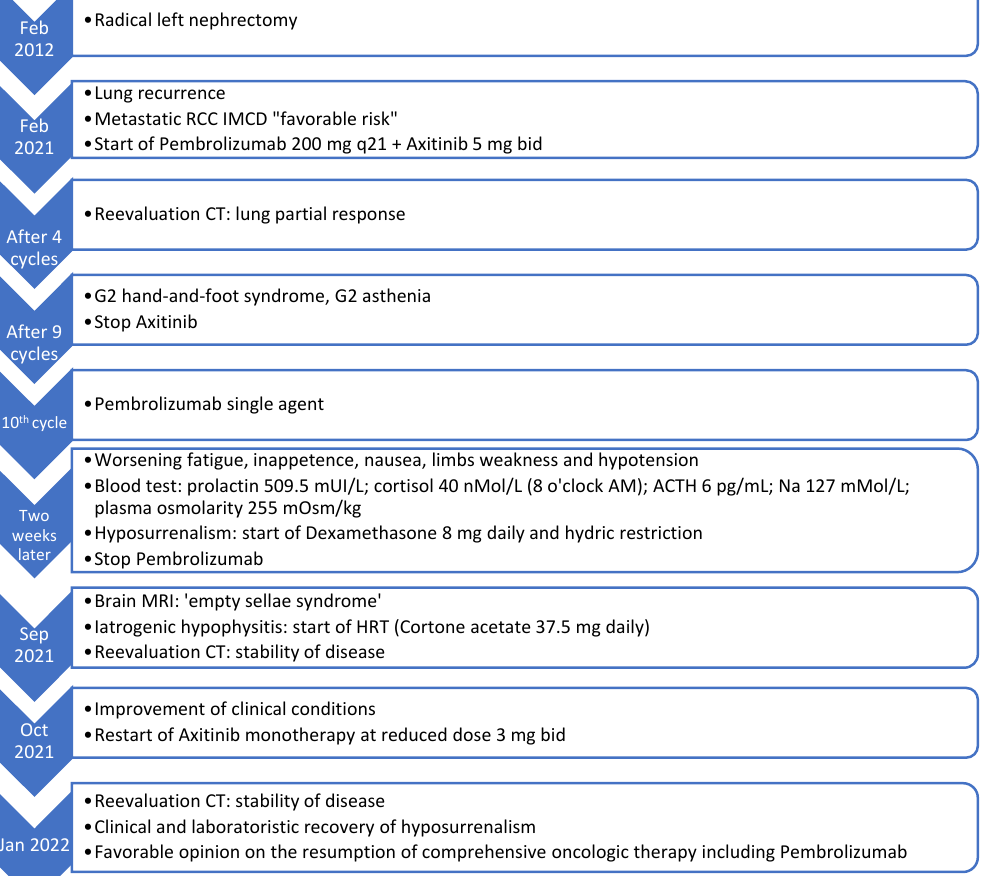
Figure 3. Events timeline of iatrogenic hypophysitis clinical case. RCC: renal cell cancer. IMDC: in ‐